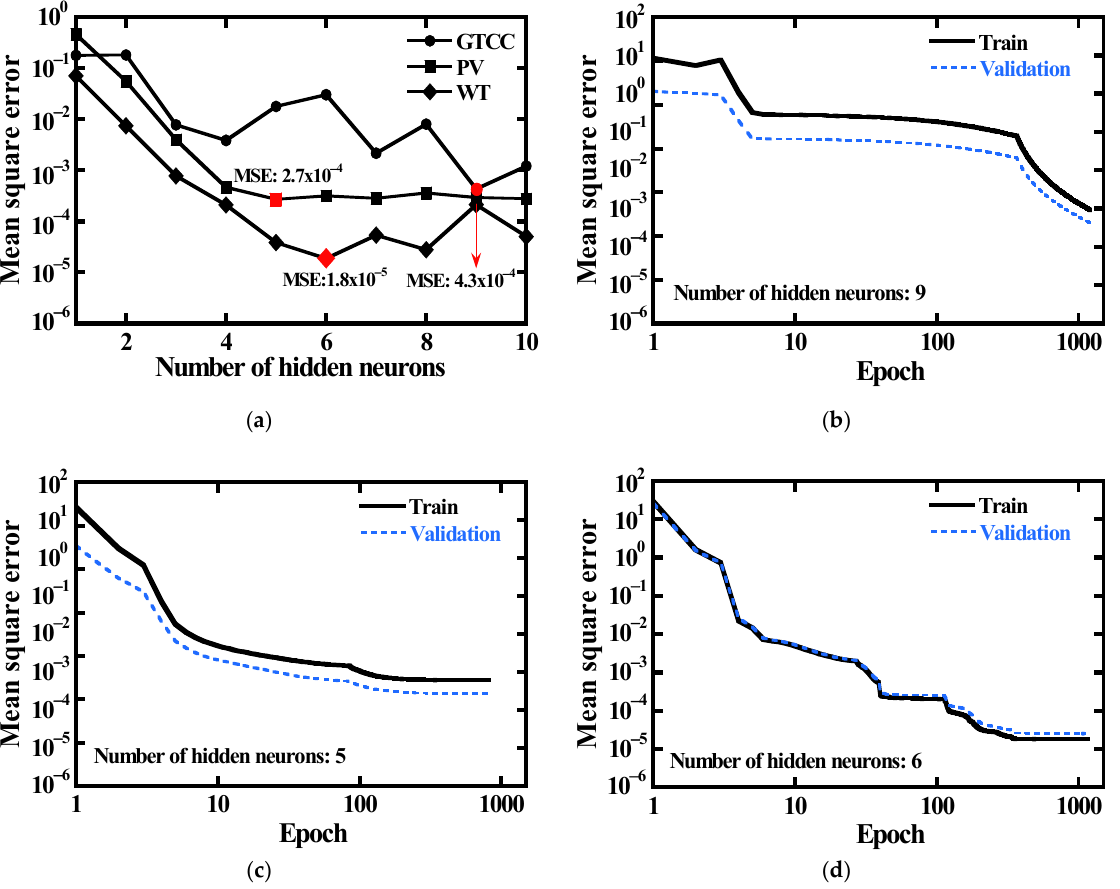
Figure 13. ( a ) MSE according to the number of hidden neurons and training results of the ANN model according to epoch: ( b ) Gas turbine combined cycle; ( c ) Photovoltaic module; ( d ) Wind turbine. The input datasets in Table 6 were used to check the performance of the ANN model, and their ranges were segmented randomly by 100. The input data were put into the phys- ics-based model and the ANN model to compare the power output. The performance